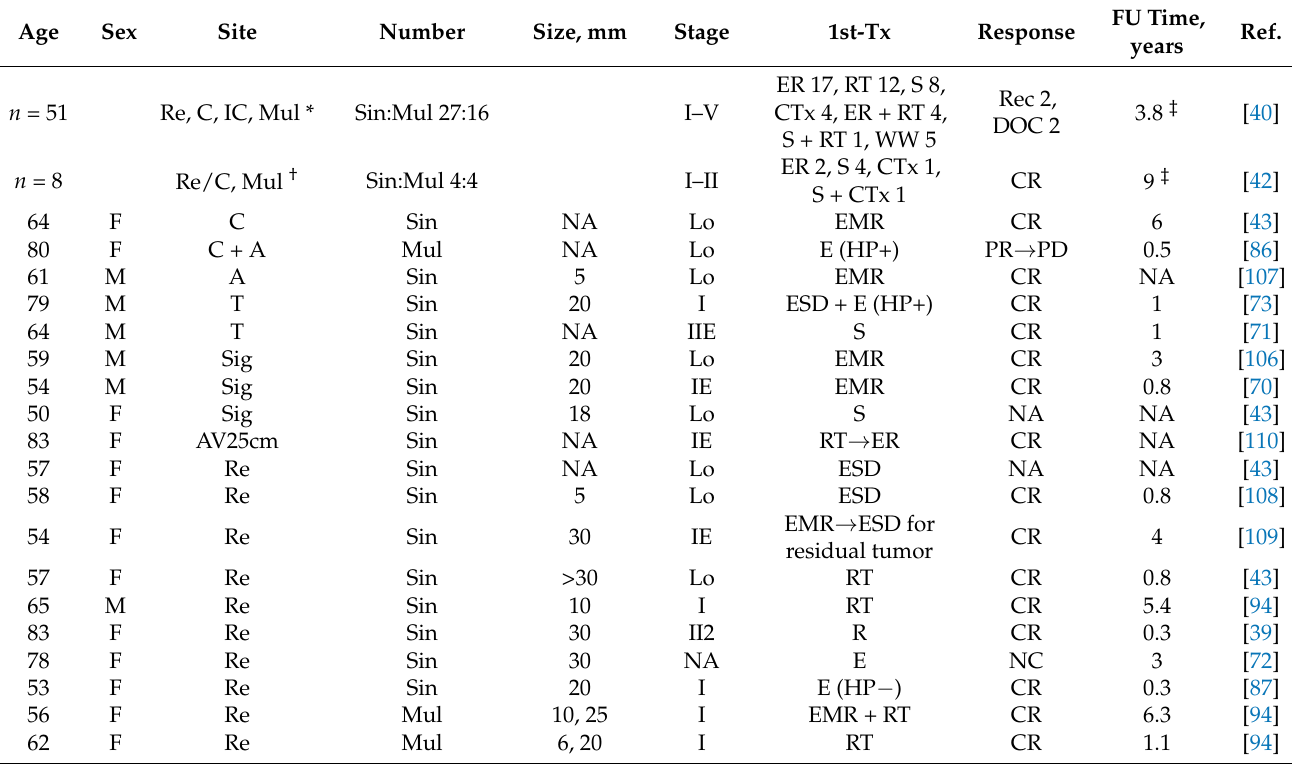
Table 4. Summary of recently reported cases of colorectal MALT